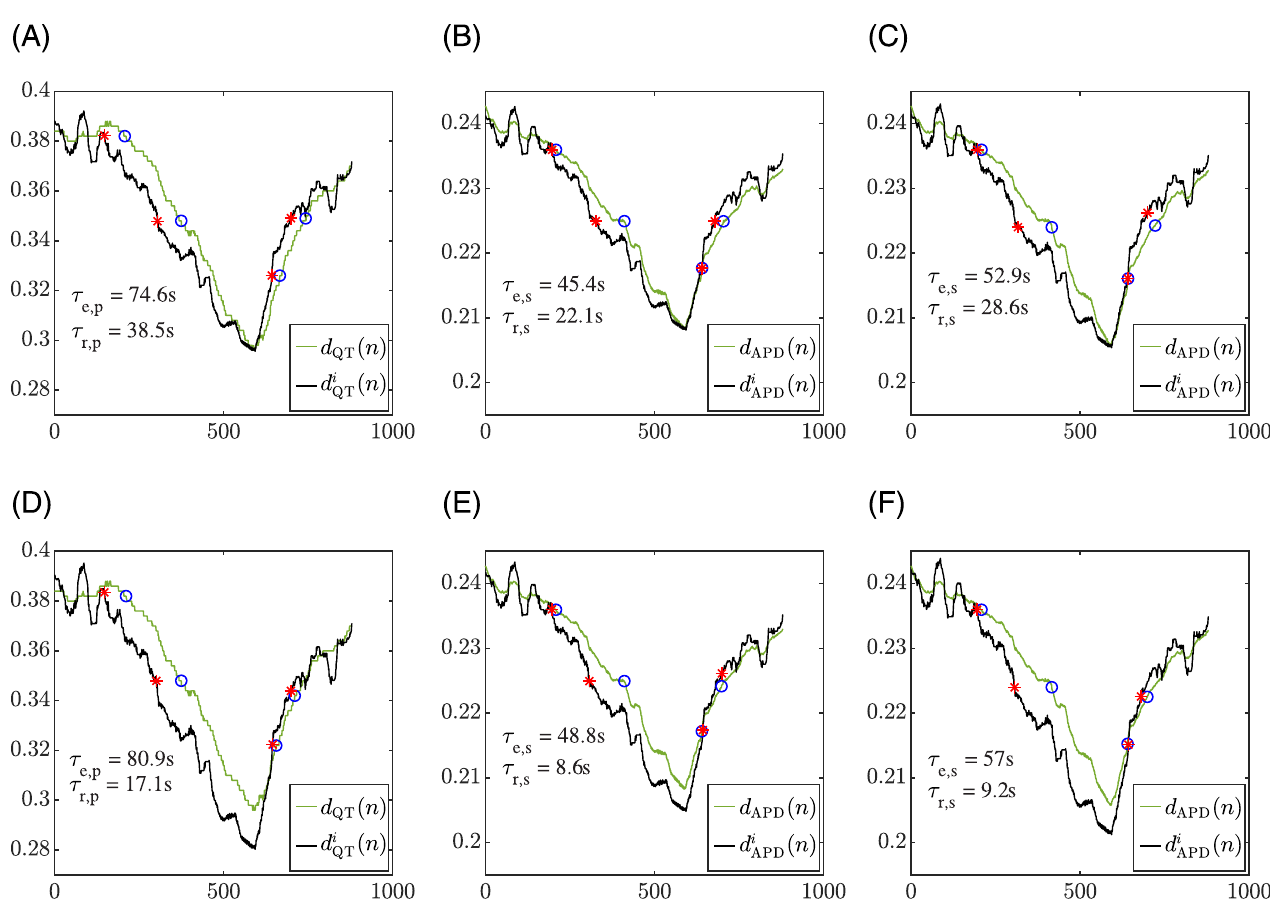
Fig 4. Left panels: QT adaptation delay between d QT ( n ) and d i ð n Þ during exercise and recovery for a patient in the study. Middle panels: APD adaptation QT delay between d APD ( n ) and d i ð n Þ during exercise and recovery in a simulated endocardial cell for constant β -adrenergic stimulation and the same HR as for APD ð n Þ during exercise and recovery in a simulated endocardial cell for the the patient in the left. Right panels: APD adaptation delay between d APD ( n ) and d i APD proposed time-varying β -adrenergic stimulation. Top panels show results using the U estimation strategy, while bottom panels use the M estimation strategy. The red points correspond to n e , o , n e , e , n r , o and n r , e , calculated as described in section 2.6, which delimit the exercise and recovery ramps in d i ð n Þ or d i ð n Þ . QT APD The blue points were identified in d QT ( n ) or d APD ( n ) as the nearest samples to the red points having QT or APD values within 2 ms of the corresponding red point value.